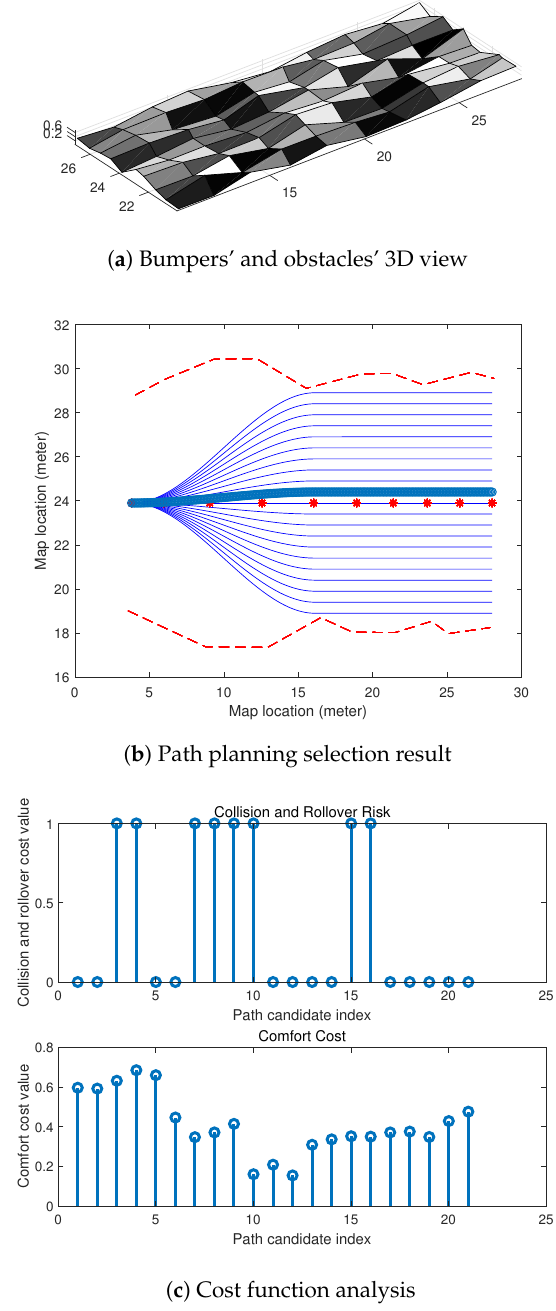
Figure 16. Path planning example: ( a ) the selected path candidate passes over a non-rollover risk pit; ( b ) the selected path candidate avoids a rollover risk pit; ( c ) the path candidate goes back to the baseline from ( b ) and avoids a collision